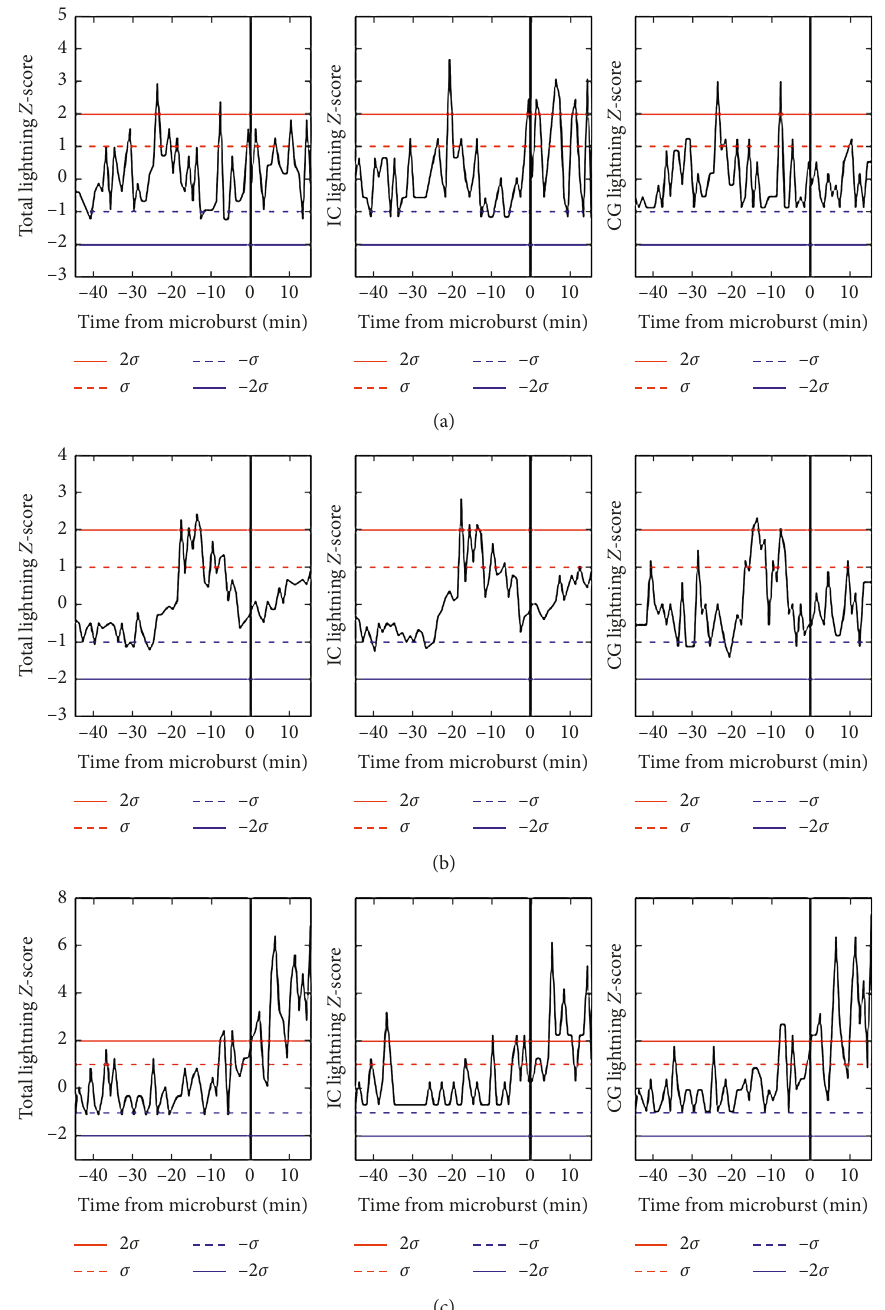
Figure 5: As in Figure 3, except for the last three cases. (a) 20150803 microburst. (b) 20160616 microburst. (c) 20160701